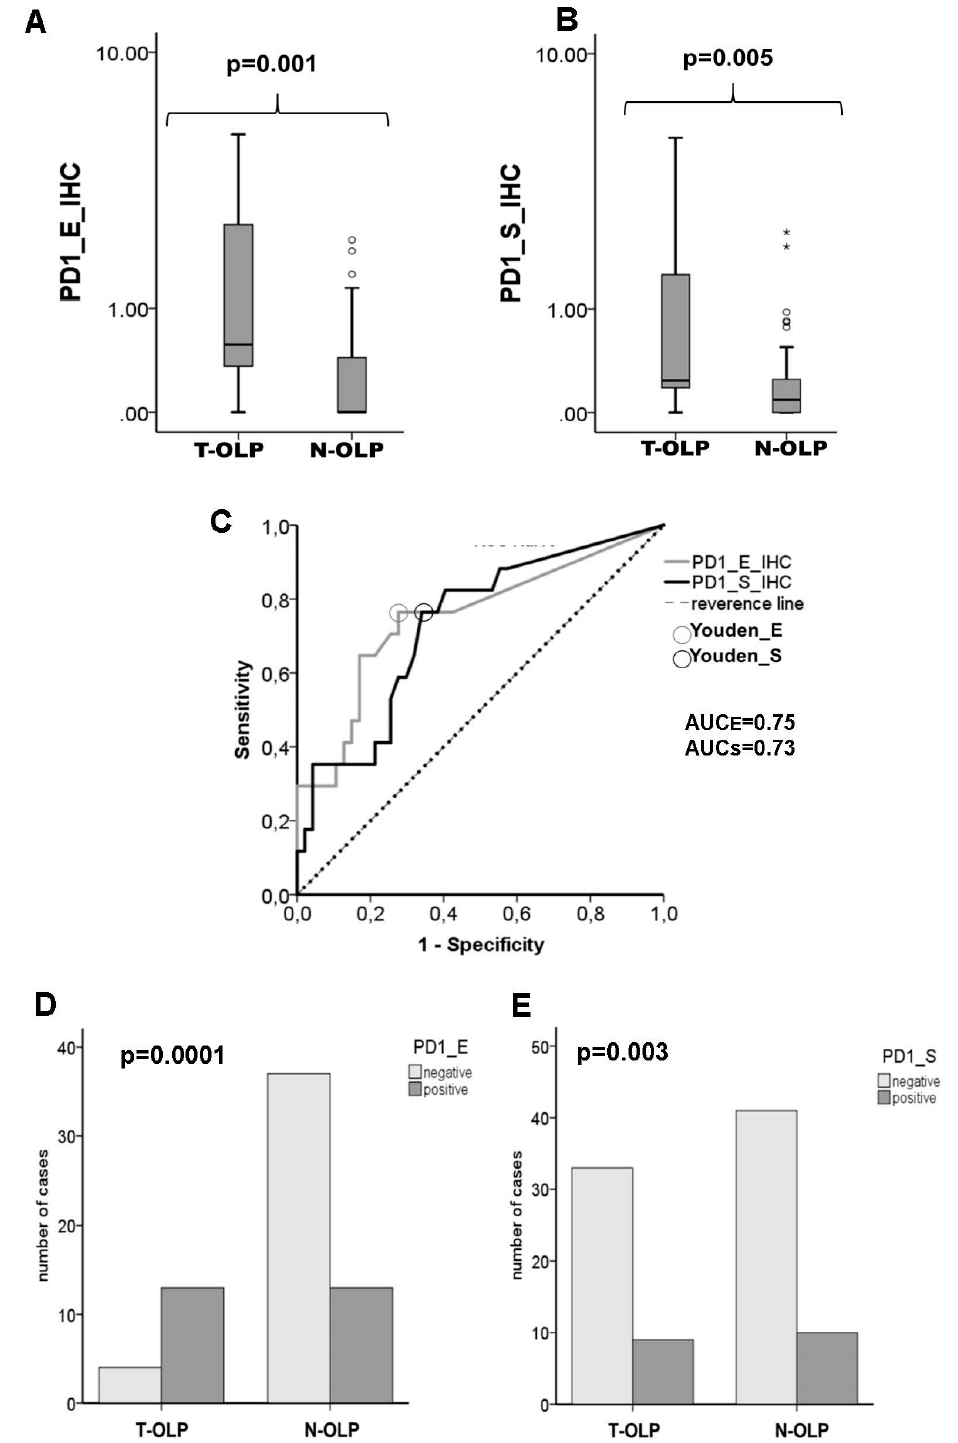
Figure 3. Comparison of the expression rates of PD-1 in the epithelium and the subepithelium of T-OLP and N-OLP determined by IHC. Boxplots and MWU-tests show a significant epithelial ( A ) and subepithelial ( B ) overexpression of PD-1 in the T-OLP group compared to N-OLP. ( C ) Receiver operating characteristic (ROC) curve and AUC value indicate a significant relation between PD-1 protein expression and malignant transformation in epithelial and subepithelial compartment (T-OLP (positive status) vs. N-OLP). A significant association between malignant transformation and protein overexpression in the epithelial ( D ) and subepithelial sections ( E ) was seen ( χ